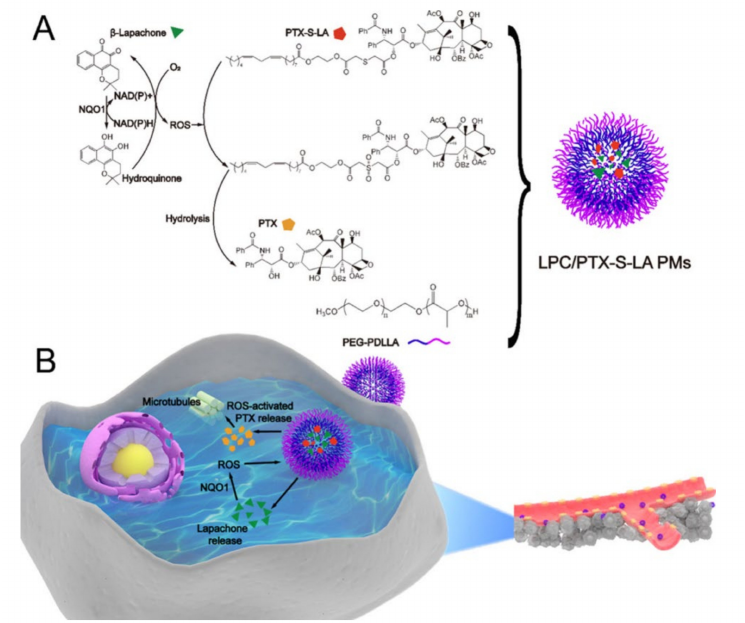
Figure 7. Sequential release by prodrug nanosystem. ( A ) Structure and nanoparticle formation process for β -lapachone (LPC), oxidation-responsive thioether-linked linoleic acid paclitaxel conjugates (PTX-S-LA), andPEG-b-poly( d , l -lacticacid)(PEG-PDLLA)( B )Uponintravenousinjection, LPC / PTX-S-LApolymeric micelles (PMs) migrate into cancer cells due to the enhanced permeability and retention (EPR) e ff